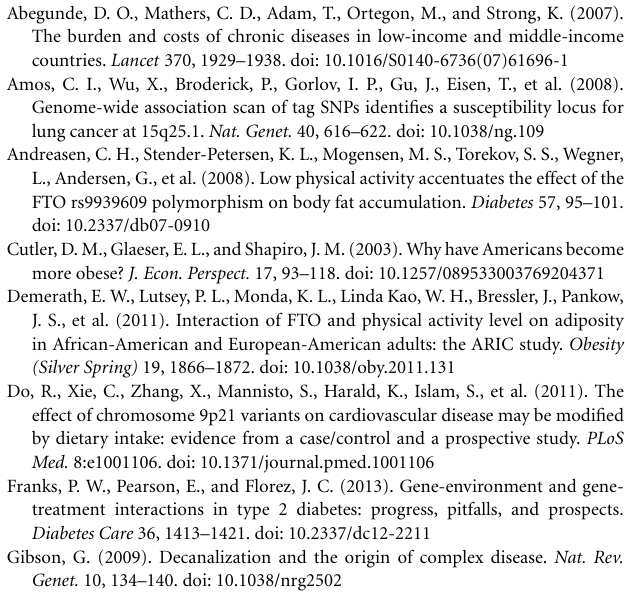
significance in a GWAS with 100% of the samples being drawn from the “ancestral” environment. Successive boxplots: the same variant drops in statistical significance when tested in GWAS in which the allele has undergone a 1.25, 1.5, 1.75, and 2-fold perturbations in 50% of the